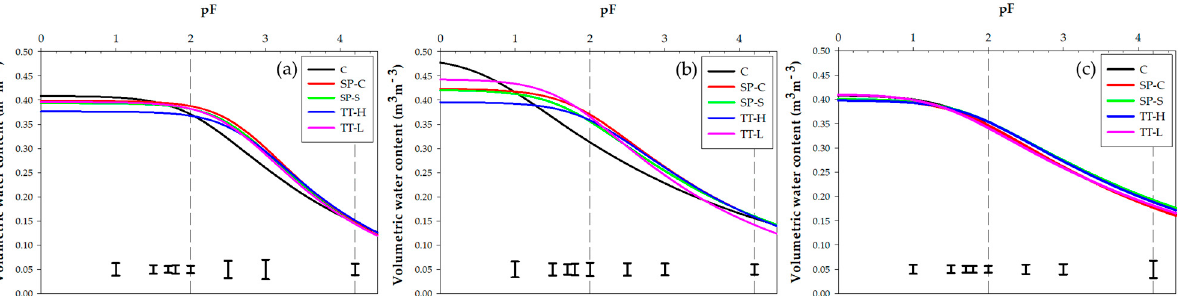
Figure 9. Water retention curves for the control and the four experimental treatments at 5 cm ( a ), 20 cm ( b ) and 45 cm ( c ) depth ( n = 3). The dashed lines indicate field capacity (pF = 2.0) and permanent wilting point (pF = 4.2). The vertical bars represent repeated-measures LSD (5%) values for the